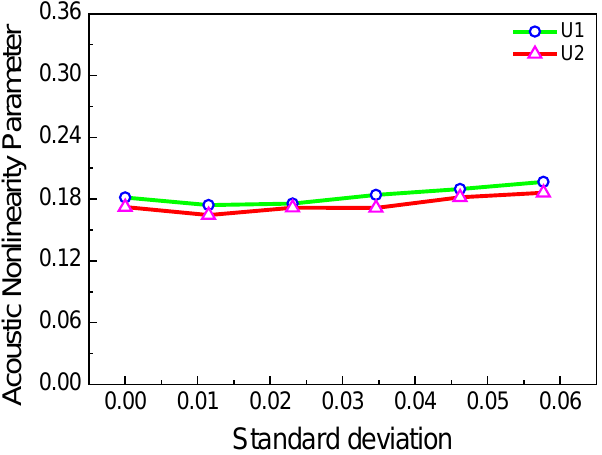
Figure 10. Acoustic nonlinearity parameter versus standard deviation of micro-crack lengths with uniform distribution ( c = 0.1, f = 1000 kHz, µ = 0.1, w % = 100%).